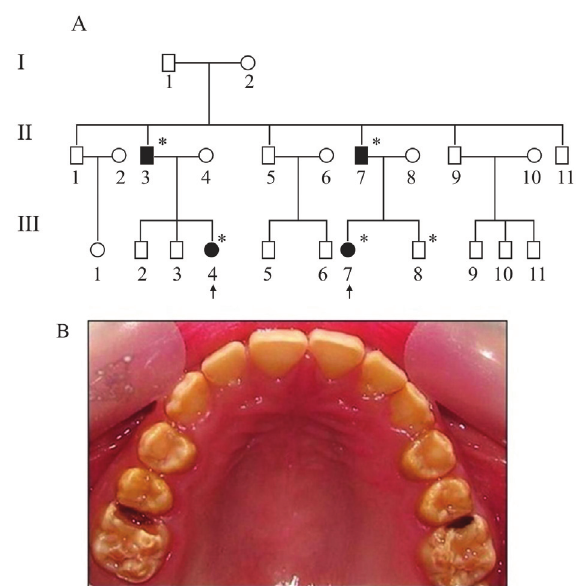
Figure 4 - Family 4. A. The pedigree indicated autosomal dominant inher- itance with eight affected members (black symbols). The arrows show the probandpatientswhowereattendedalongwiththeirmother.Theasterisks indicate individuals who were analyzed clinically and whose ENAM gene was sequenced. B,C Photographs of proband III:1. The phenotype was classified as generalized hypocalcified. Note the characteristic indications of wear on the occlusal surfaces and therefore high tooth sensitivity. This patient also showed anterior open bite.